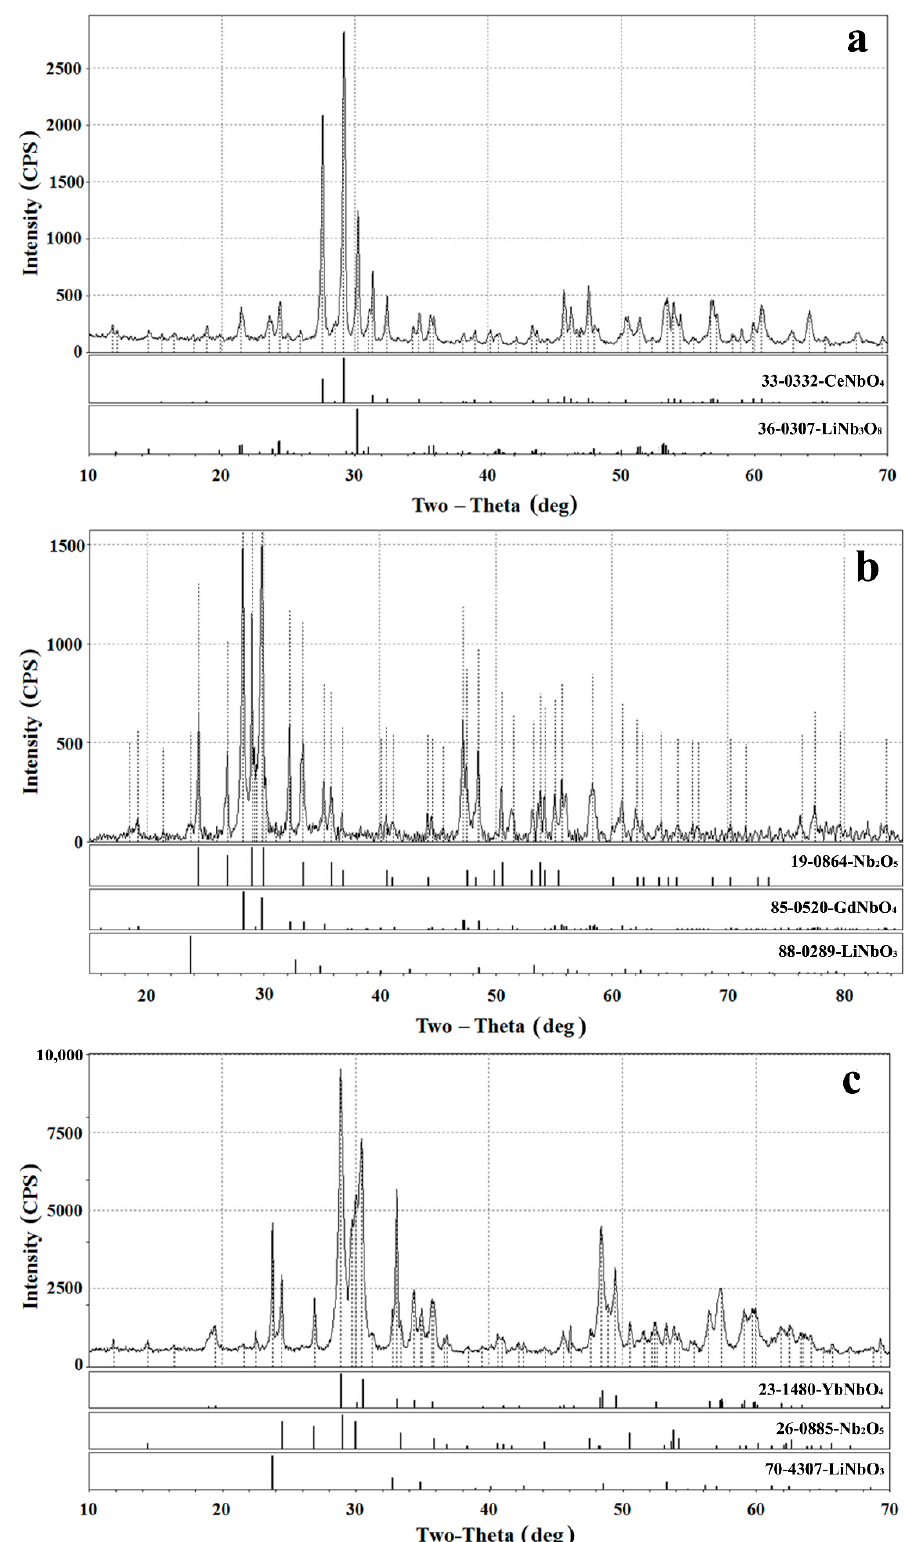
Figure 9. X-ray diffractograms of the products of the lithium ions heterovalent substitution reaction in LiNbO 3 obtained after holding its powders in molten LiCl-LnCl 3 mixture where Ln = Ce ( a ), Gd ( b ), Yb ( c ) under inert gas (argon) atmosphere at 700 ° С .